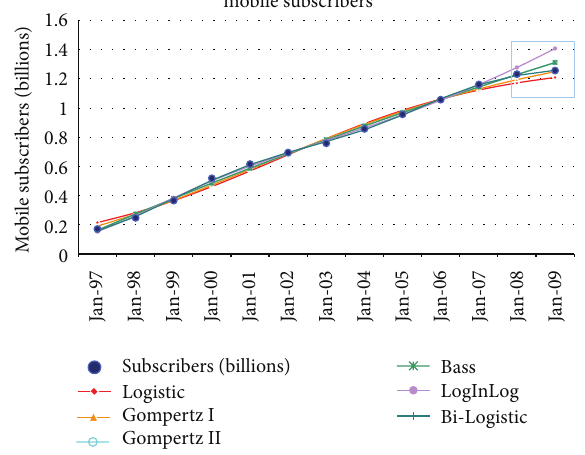
Figure 20: The forecasting performance of the diffusion models (forecast window—2 years ahead) for the total number of OECD subscribers.